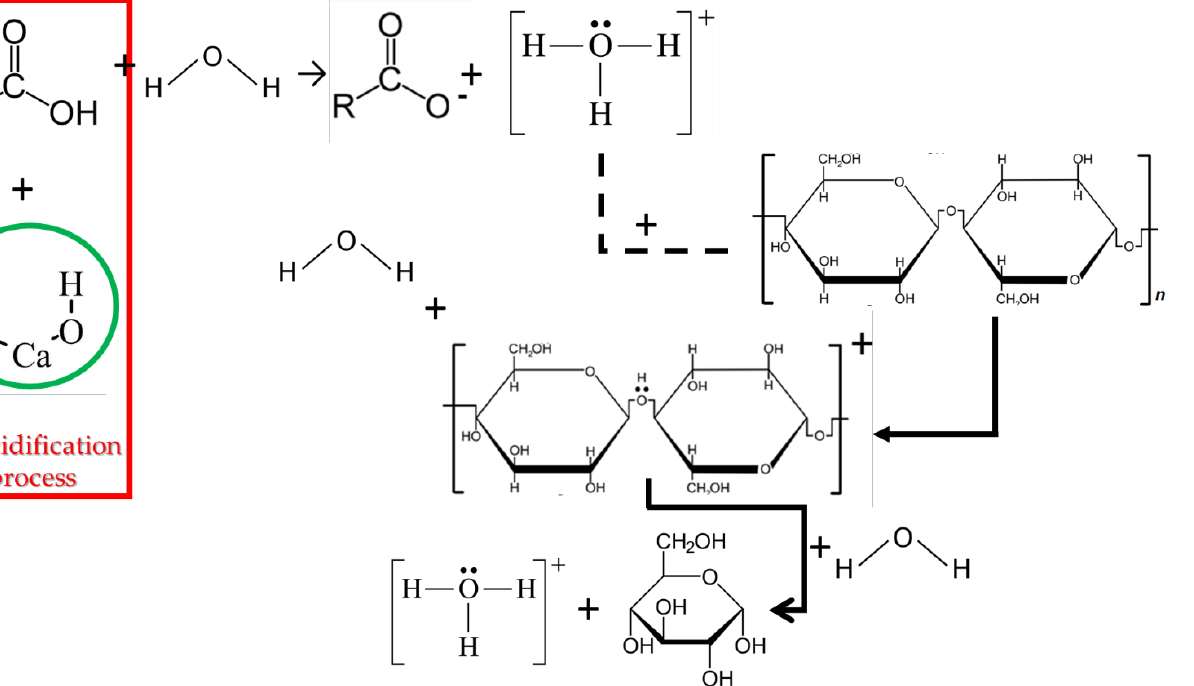
Figure 2. Acid degradation of cellulose, one of the most important degradation processes of paper artifacts, and the deacidification process (red square) realized by the addition of an alkaline reservoir (exemplified by calcium hydroxide).